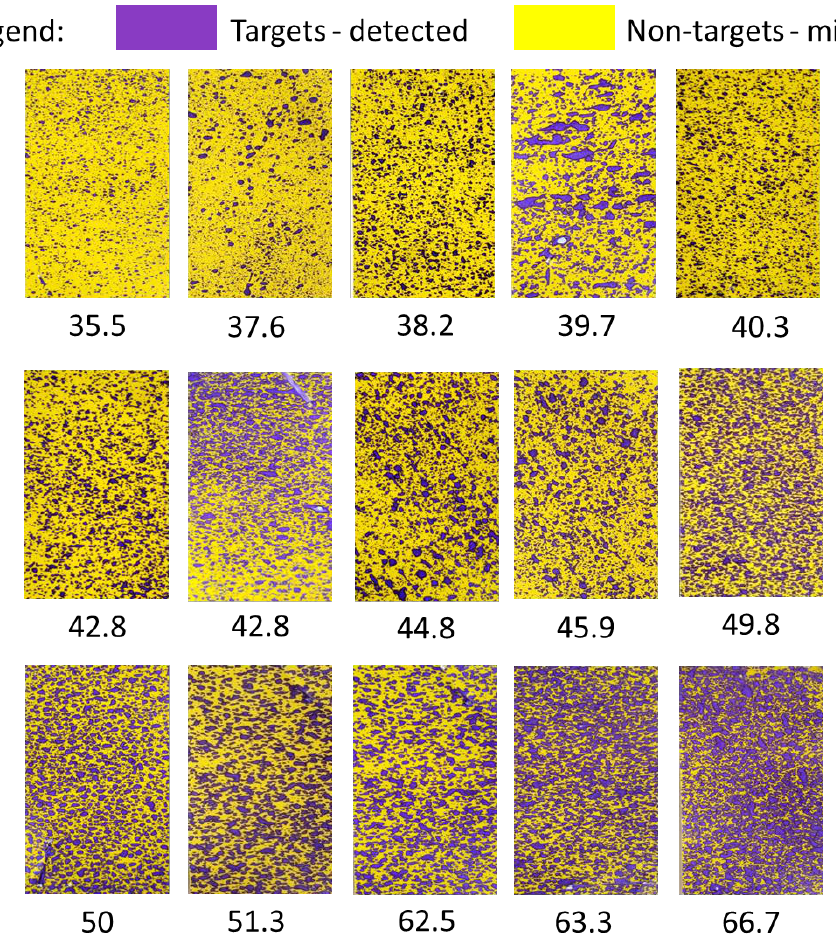
Figure 7. Processed images of water-sensitive papers for variable rate application treatment showing the percent areas coverage of targets (purple) and non-target (yellow) missed during variable rate application of the spraying liquid. The numbers below each image of the water-sensitive paper represent blue ratio; i.e., ratio (to be considered as percent area coverage of variable rate application treatment) of image pixels turned into blue after receiving the spraying liquid (target detected) to the total image pixels.